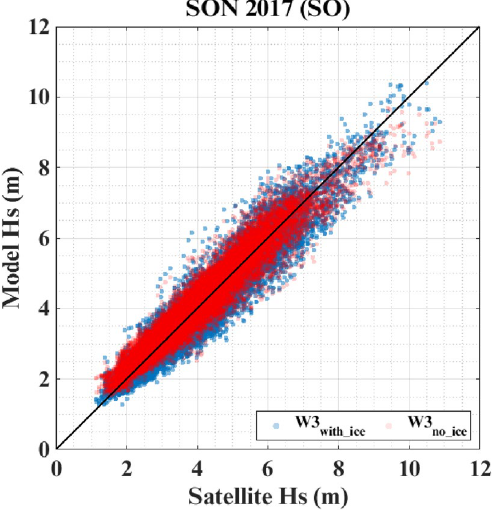
Figure 6. Satellite Hs comparison with W3 with_ice and W3 no_ice simulations for the ice-free regions of SO (55–40° S, 40–110° E) for SON of